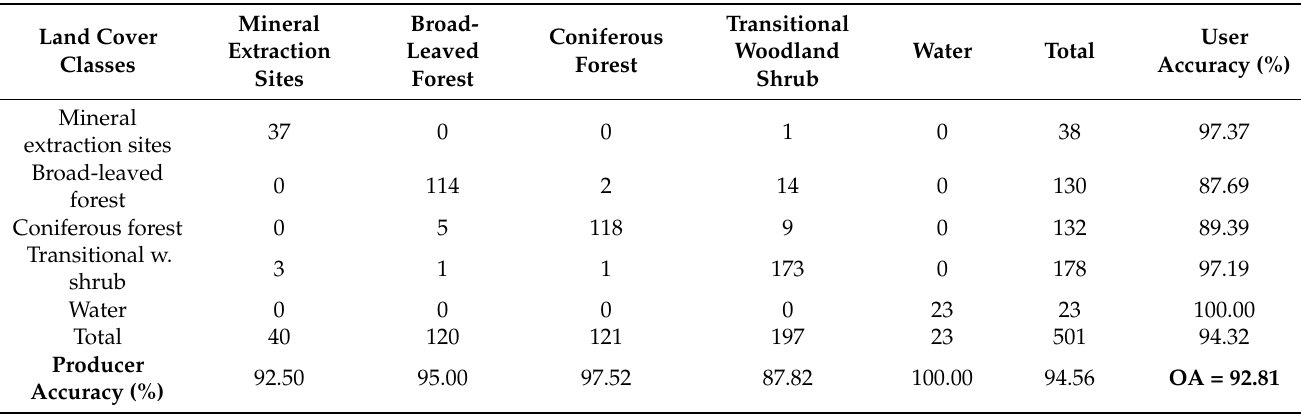
Figure 6. The results of the PlanetScope image classification, random trees method. Table 1. The assessment parameters for the random trees method. Total estimated, overall accuracy (OA) was shown as a bold value.